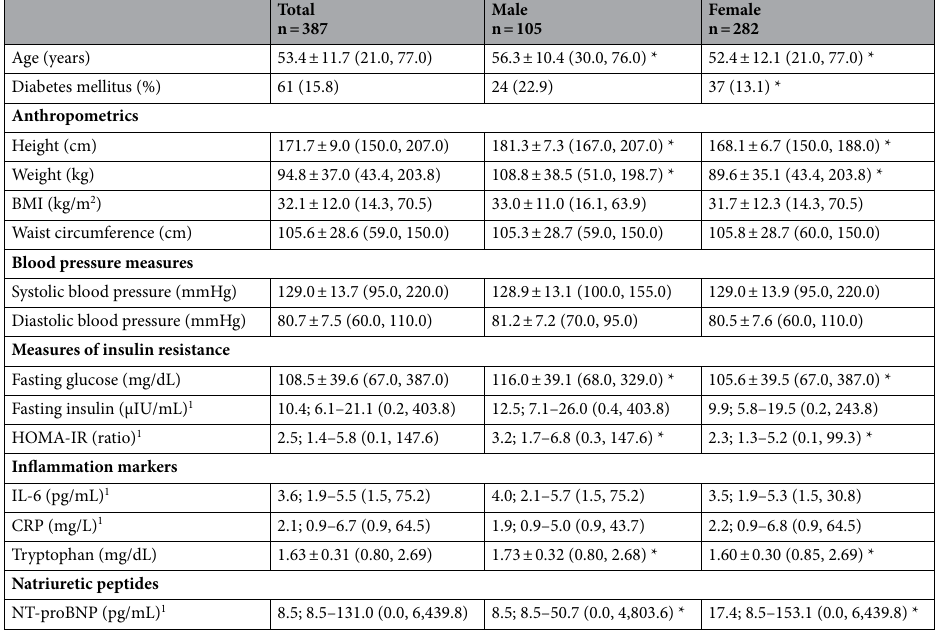
Table 2. Characteristics of the FoCus cohort. Values are presented as mean ± SD for continuous variables or number (frequency) for categorical variables with minimum and maximum in parentheses. 1 Skewed values are expressed as medians with interquartile ranges and with minimum and maximum in parentheses. Statistical significance between males and females was determined with unpaired t test for normally distributed data, with Wilcoxon test for skewed data, and with χ 2 test for categorical data. An asterisk (*) denotes significant differences between both groups (p < 0.05). BMI, body mass index; CRP, C-reactive protein; HOMA-IR, homeostatic model assessment of insulin resistance; IL-6, interleukin 6; NT-proBNP, N-terminal pro brain natriuretic peptide.